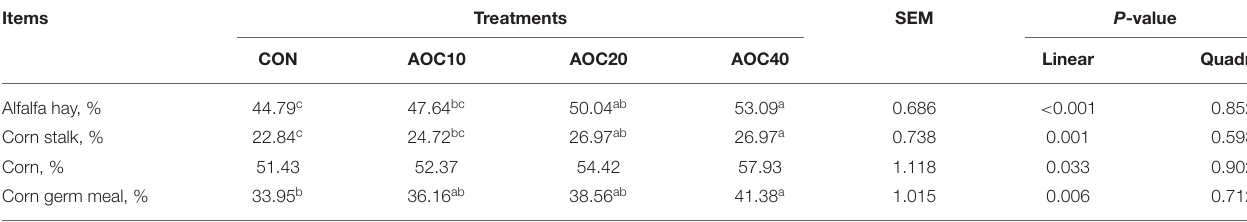
TABLE 3 | Effects of different dietary levels of Aspergillus oryzae culture supplementation on the DM disappearance of different feed materials.